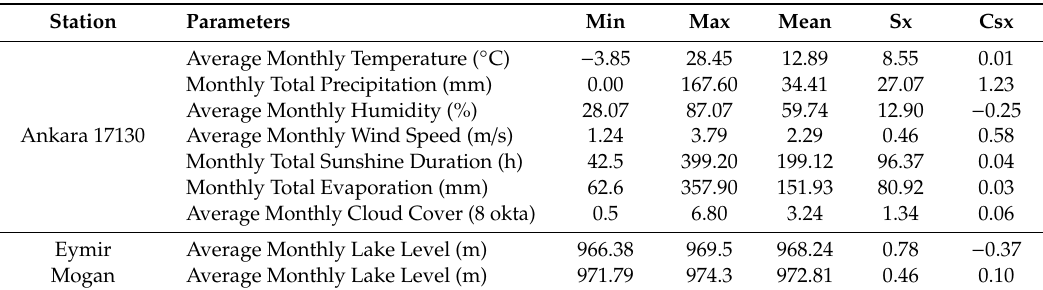
Table 2. Statistical characteristics of the